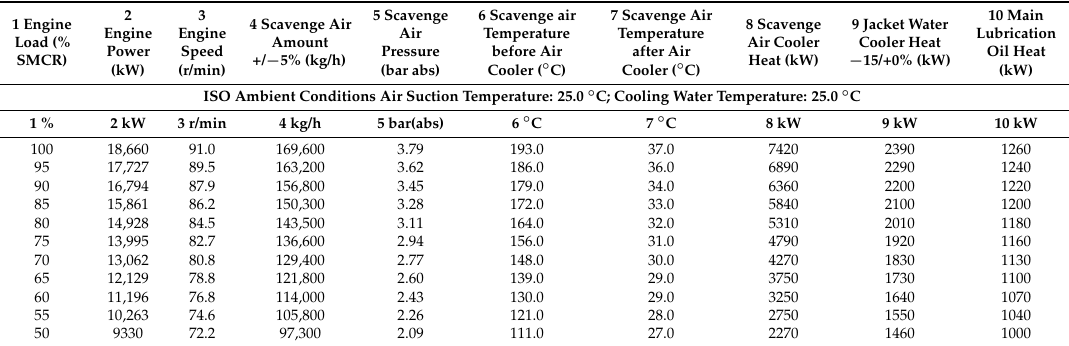
Table 2. Heat exchanger power at various engine loads, ISO conditions [27]. 1 Engine Load (%